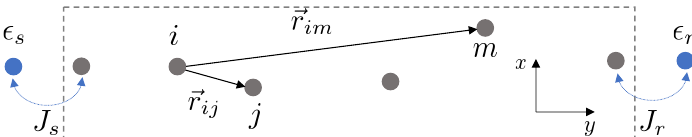
Figure 1: Schematic of a position (and energy) disordered chain of spins i , j ,..., m ,... in the x y plane. The spin chain is coupled with rates J (s) and receiver (r) spins having energies ε